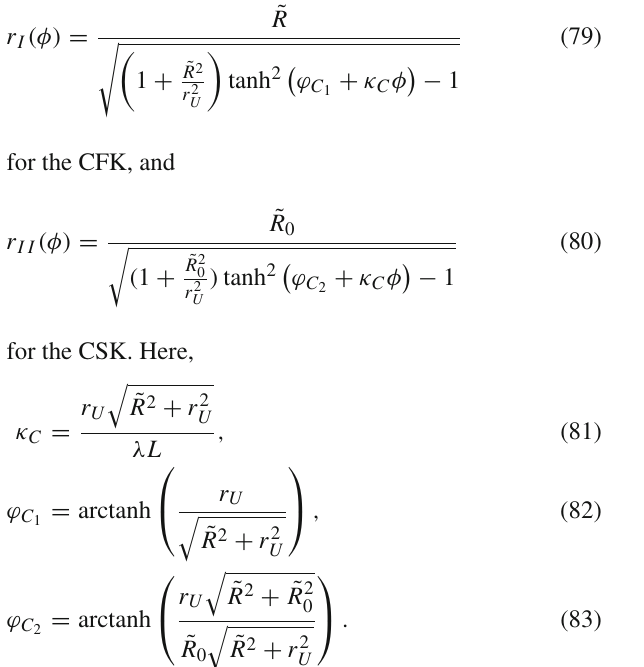
Fig. 10 The captured trajectories for particles approaching from r 0 = 5, plotted for Q = 1, λ = 10 and L = 2. Accordingly, the critical impact parameter is b U ≈ 2 and the trajectories plotted here correspond to b = 1 . 18 , 1 and 0 .